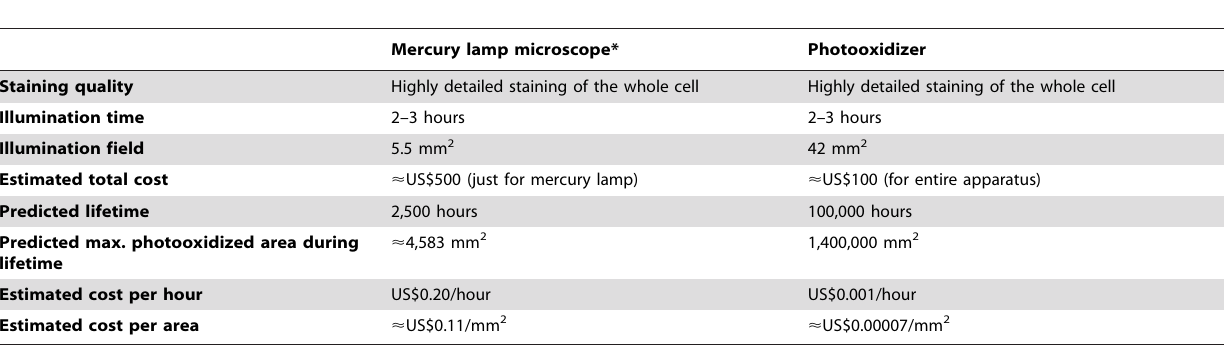
Table 1. Comparison between the new photooxidizer illumination method and conventional mercury arc lamp microscope